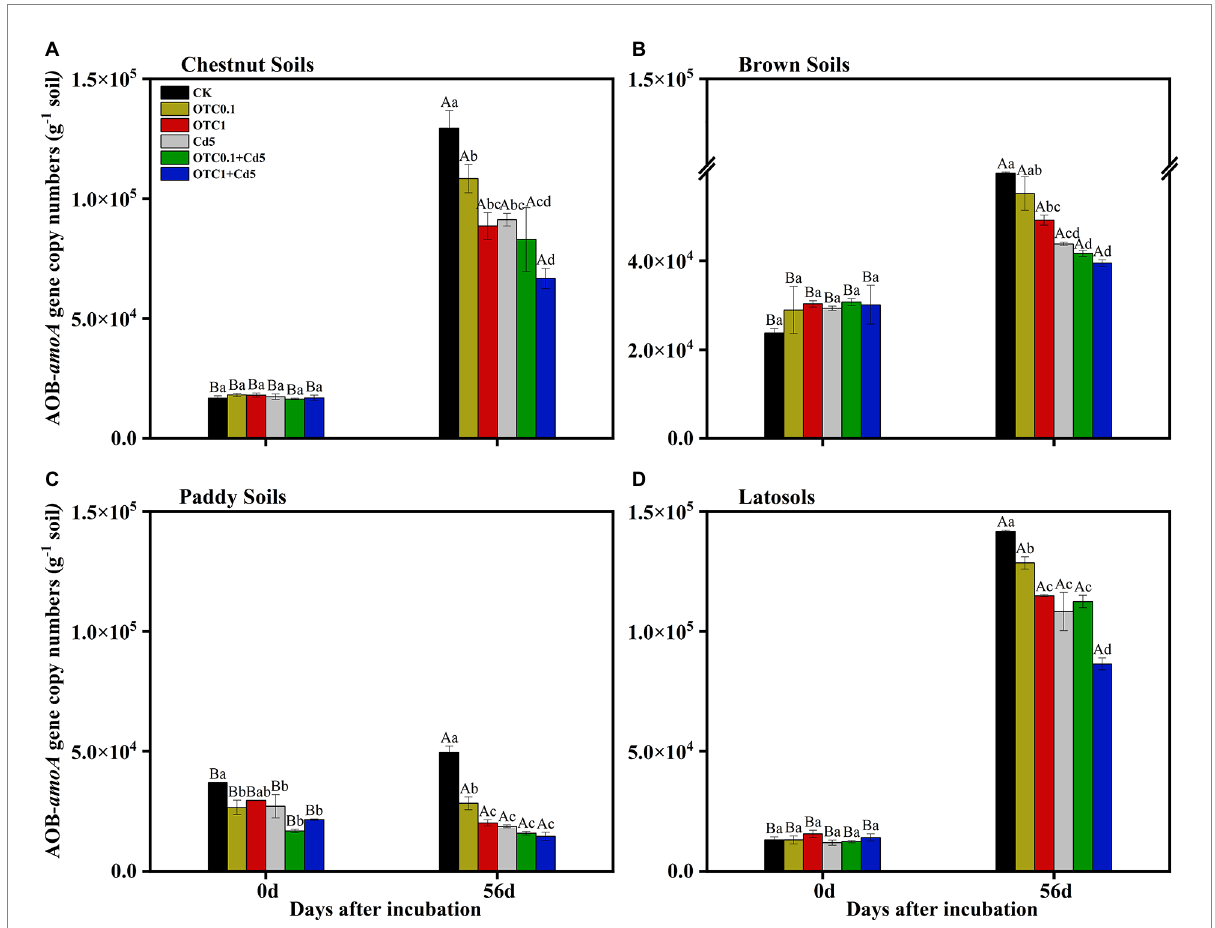
FIGURE 4 Abundance of AOB amoA gene in chestnut soils (A) , brown soils (B) , paddy soils (C) , and latosols (D) under CK, OTC0.1, OTC1, Cd5, OTC0.1 + Cd5, and OTC1 + Cd5 treatments at day 0 and day 56. The vertical bars indicated the standard errors of the mean of triplicate samples. Different lowercase letters above the error bars indicated significant differences among treatments ( p < 0.05). Different uppercase letters above the error bars indicated significant differences among sampling time points under the same treatment ( p < 0.05). CK, control treatment without